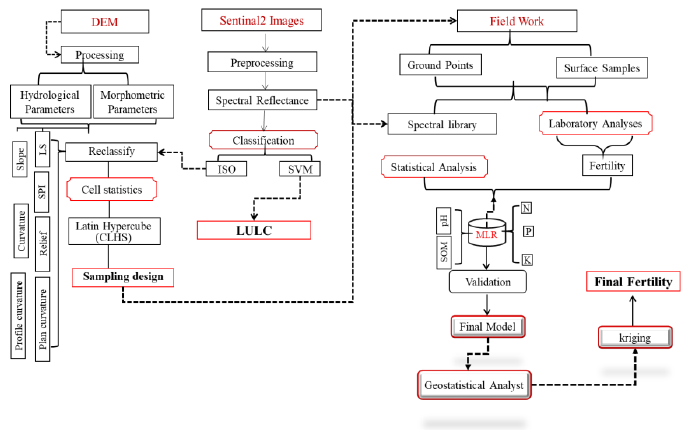
Figure 1. Schematic diagram of current work methodology; note: MLR = multi linear regression.